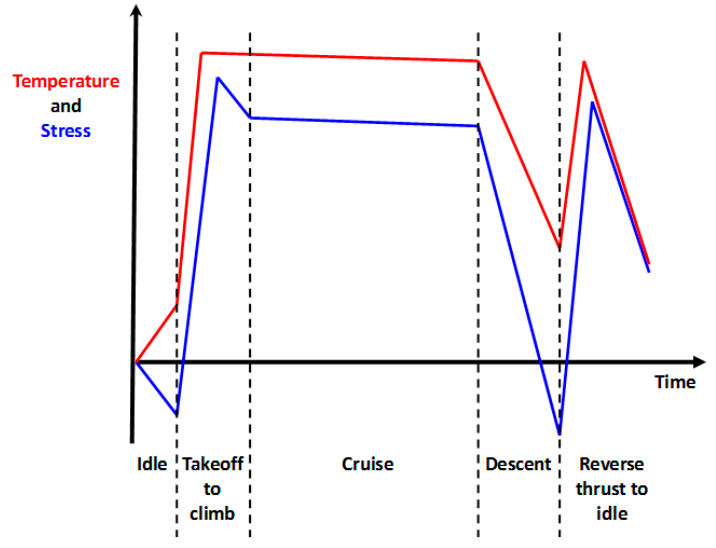
Figure 10. Turbine conditions during a civil engine flight cycle based on Marchand et al. [27].